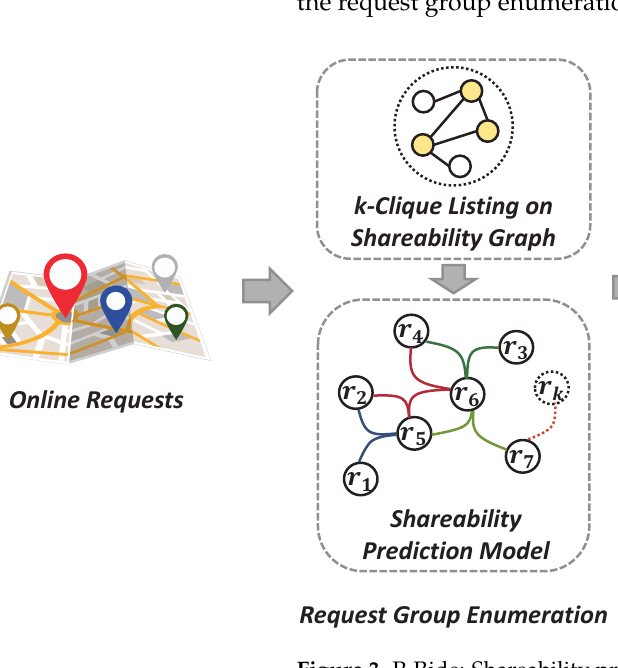
Figure 3. P-Ride: Shareability prediction-based ridesharing